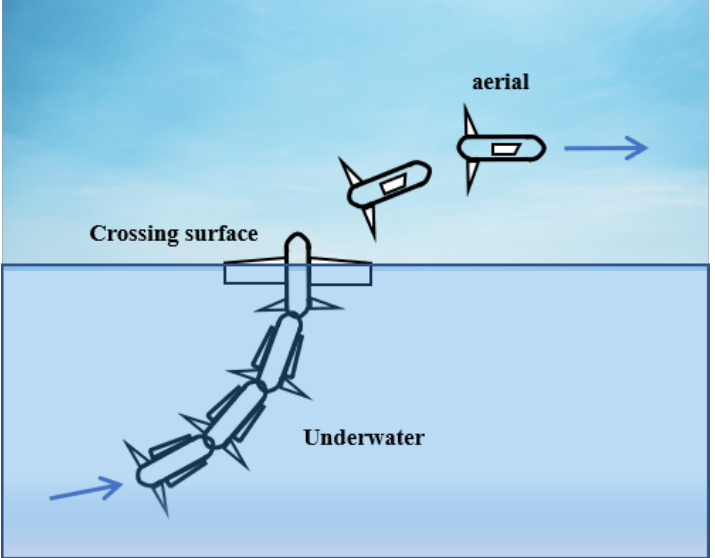
Figure 3. The three mission modes of the HAUV. The edge weight is different per unit of distance for each situation: the fulfill per meter underwater is 5 times of that of flying. The motion constraints also vary: the maximum velocities are: 3 m/s underwater, 10 m/s aerially, and 1 m/s while transitioning (between water and air). The accelerations are: 2 m 2 /s underwater, 3 m 2 /s aerially, and 1 m 2 /s while